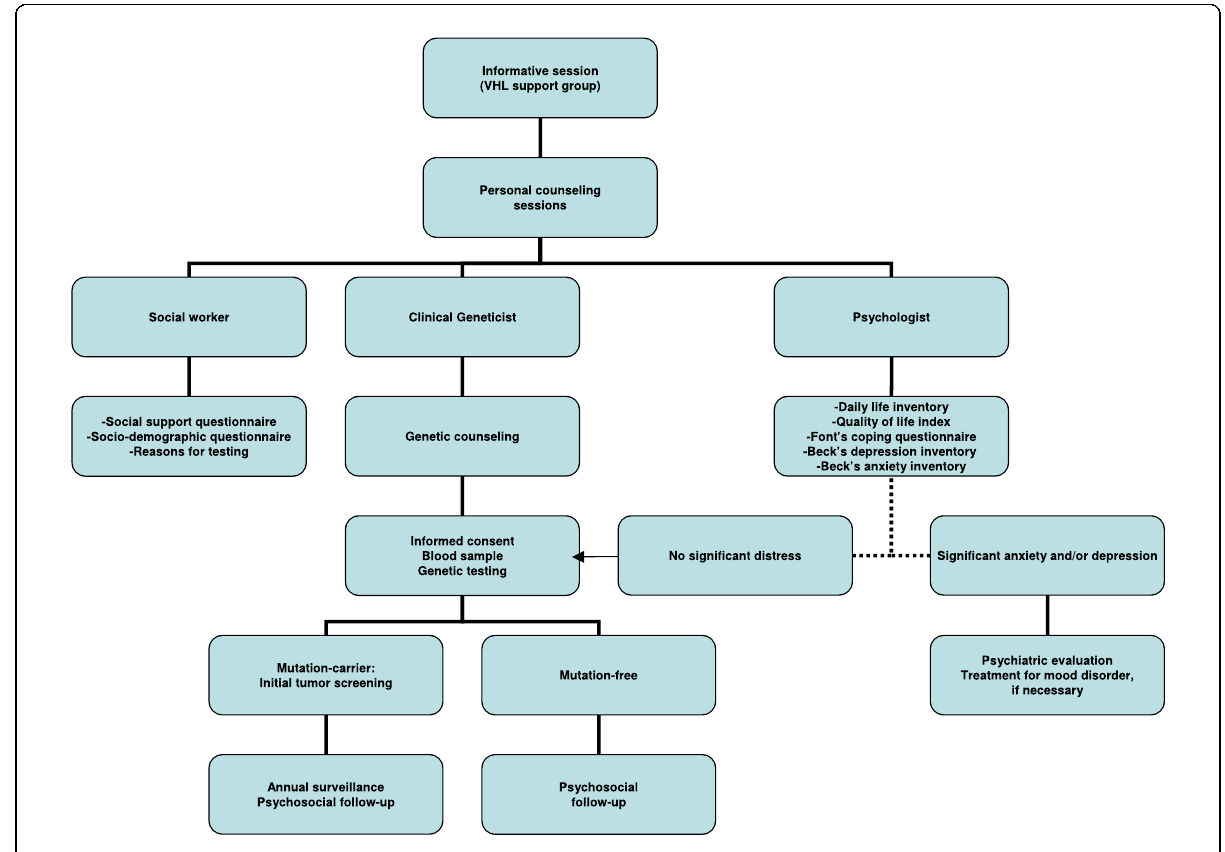
Figure 1 Scheme for genetic counseling and testing in our cohort of families with VHL disease .